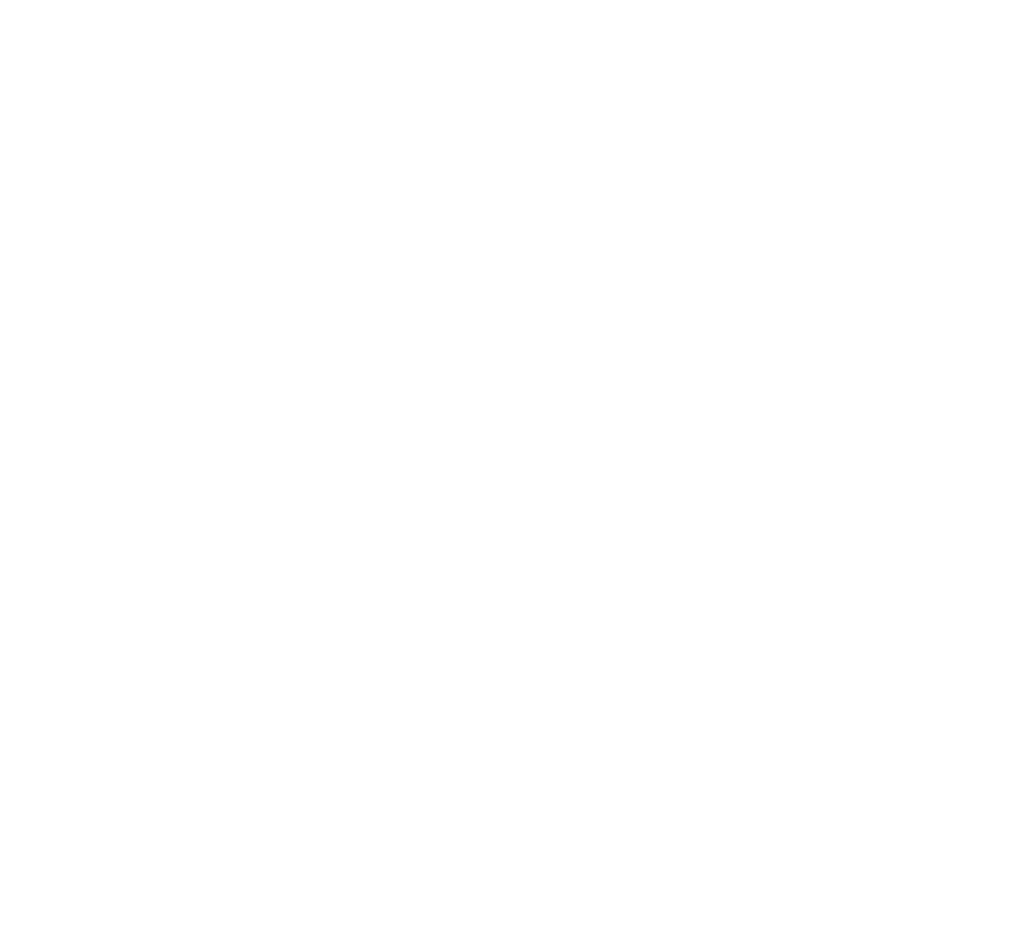
Figure 1. Cumulative reported HIV case rates per 100,000, 1982–2012 ................................................. 11 Figure 2: Reported cases and deaths annually in Jamaica, 1982-2012 .................................................... 22 Figure 3: Estimated distribution of incident HIV cases in 2012 ................................................................... 23 Figure 4: HIV prevalence among public antenatal clinic attendees (15-24) in Jamaica, 1989-2012 Figure 5: HIV Prevalence among 15-24 years ANC attendees and all attendees, 15-49 years, 2002- Figure 6: Declining HIV Prevalence among CSW, 1990-2011 ....................................................................... 27 Figure 7: Logo for Jamaica’s Justice for All Programme of activities ......................................................... 30 Figure 8: Parliamentarian cluster consultation, Justice for All Programme ............................................ 31 Figure 9. Launch of the National Workplace Policy on HIV and AIDS – White Paper and the OSH Profile of Jamaica (December 2013) featuring members of Parliament & Government, Union Representatives, Private Sector Representatives, International Funders and the Figure 10. Volunteers from World AIDS Day 2013 volunteers wearing T-shirts displaying Figure 11. “HIV Test: Mek we dweet” brochure ..........................................................................................